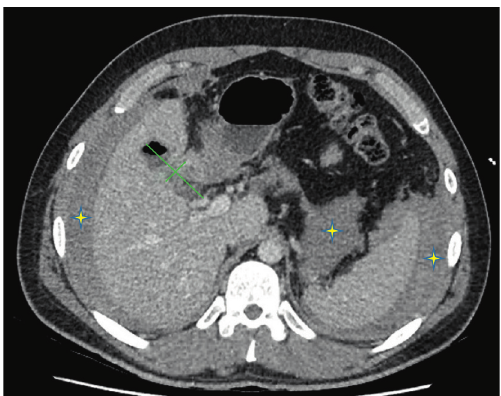
Figure 1: Computed tomography scan of the abdomen in the axial plane showing a gallbladder fossa collection (green marks), ret- roperitoneal, perihepatic, and perisplenic haematomas (yellow stars).